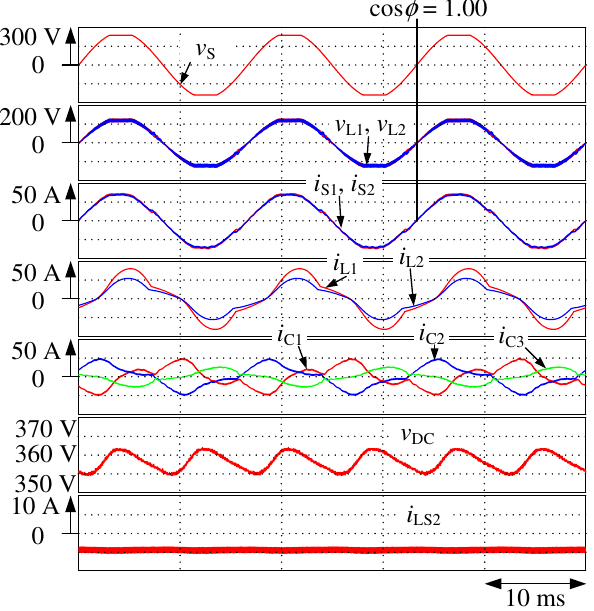
Figure 7. Experimental results for Figure 5 during battery-charging operation.